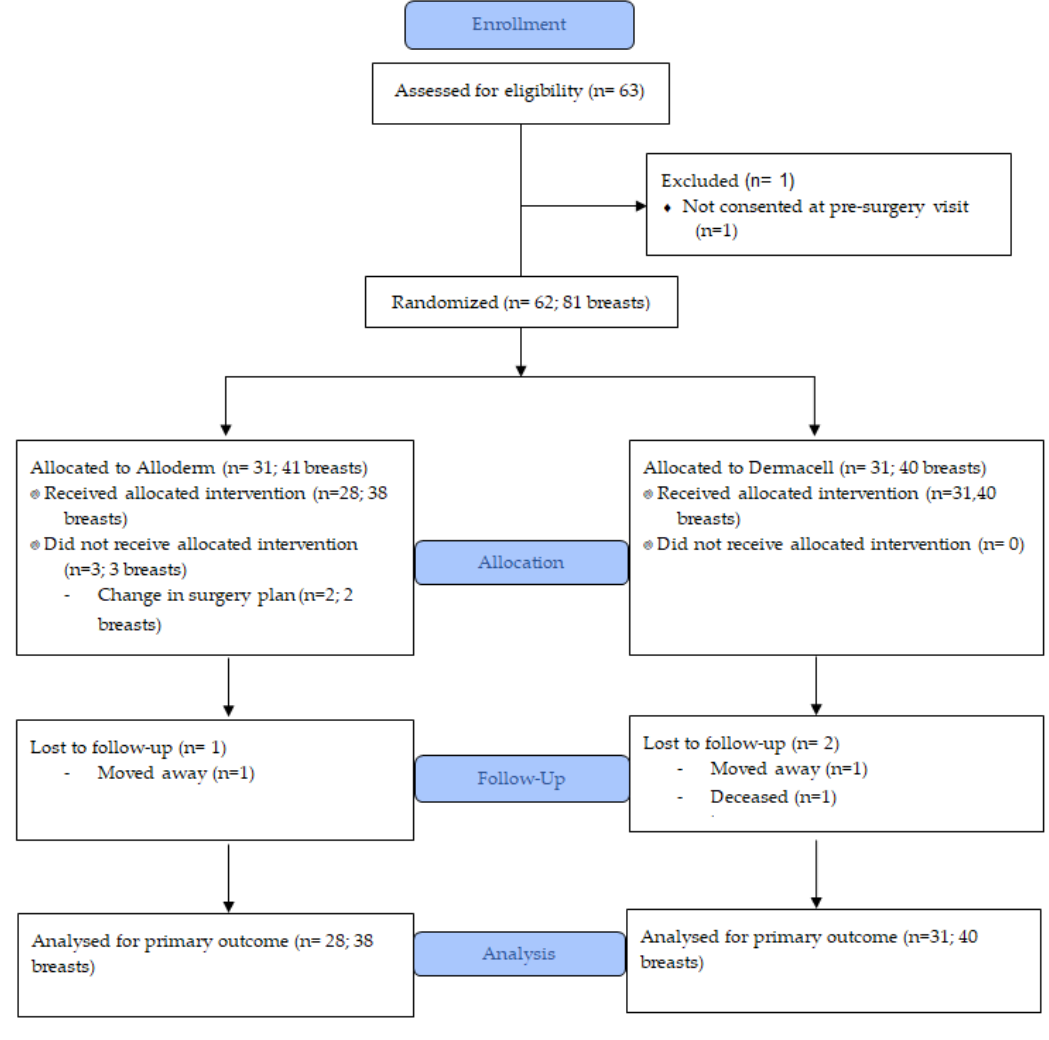
Figure 1. CONSORT diagram. Table 1. Baseline demographic and clinical characteristics. All values are number (percentage) unless otherwise